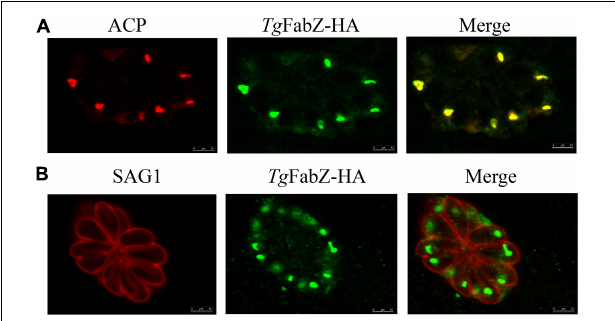
FIGURE 1 | Colocalization of FabZ and apicoplast in T. gondii as determined by indirect immunofluorescence analysis. (A) Colocalization of acyl carrier protein (ACP) in the apicoplast (red) and Tg FabZ-HA (green). (B) Colocalization of the plasma membrane protein SAG1 of T. gondii tachyzoites (red) and Tg FabZ-HA (green). The results indicate that FabZ is located in the apicoplast. Scale bars, 10 µ m.